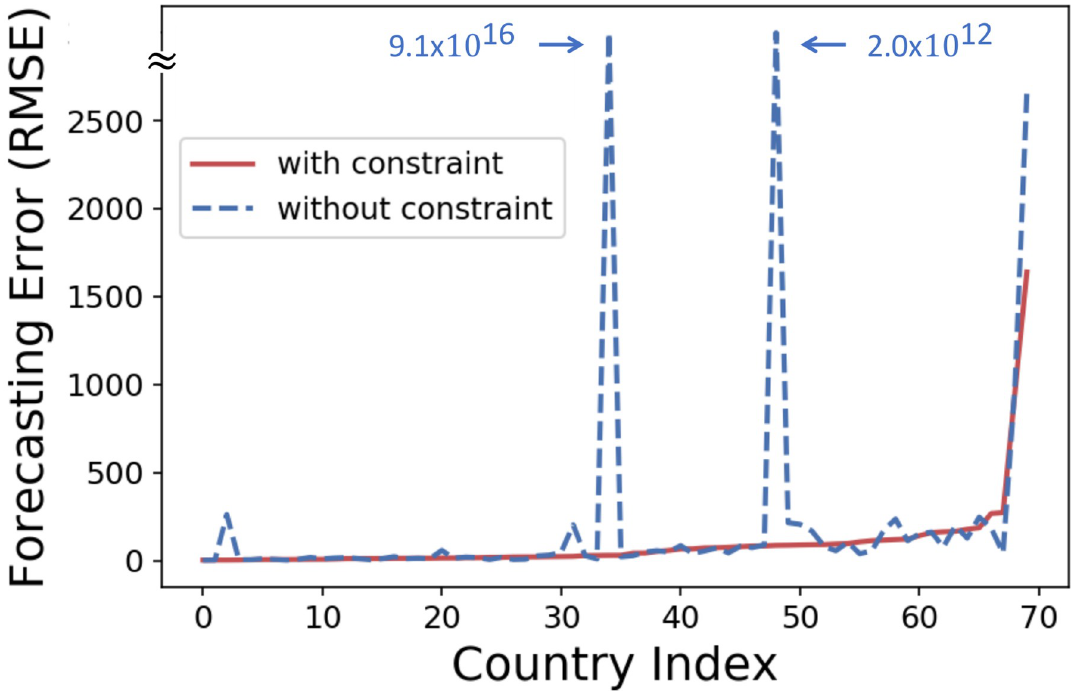
Fig 6. Ensuring the length of the last segment in the training set to 37 days is helpful for accurate prediction. NLLD without the constraint sometimes greatly overestimates the numbers of infected and recovered individuals, and the constraint helps prevent such absurd predictions. Moreover, the constraint was beneficial in 39 countries out of the 70 countries. The countries are indexed in the order of the forecasting error of NLLD with the constraint.